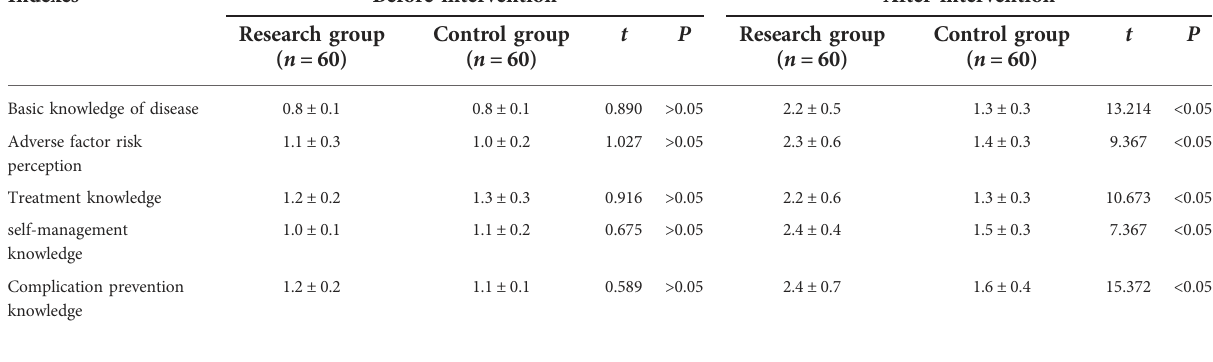
TABLE 3 Comparison of self-ef fi cacy levels before and after intervention in the two groups (score). Indexes Before intervention After